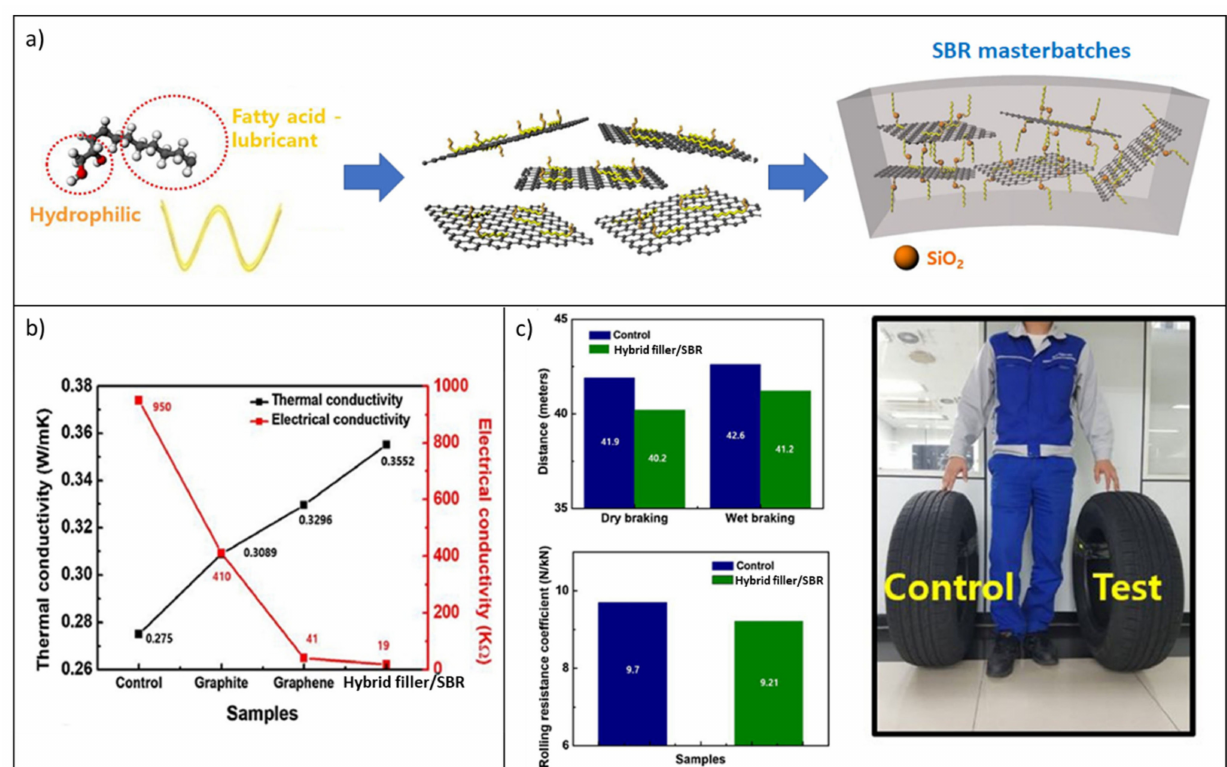
Figure 24. ( a ) General scheme of the Hybrid/SBR nanocomposites’ preparation; ( b ) Thermal and electrical conductivities of the SBR nanocomposites with different filler materials; ( c ) Characterization of tread compounds (control and those made with nanocomposites enclosing hybrid fillers). Modified according to [213]. Copyright© 2018 Published by Elsevier B.V. on behalf of The Korean Society of Industrial and Engineering Chemistry. All rights